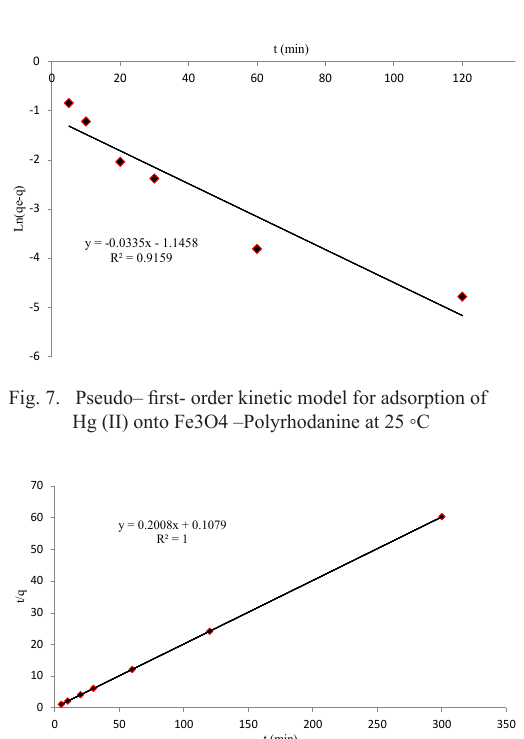
Fig.8: Pseudo-second-orderkineticmodelforadsorptionofHg(II)ontoFe 3 O 4 –Polyrhodanineat25 ◦ C Fig. 8. Pseudo- second- order kinetic model for adsorption of Hg (II) onto Fe3O4 –Polyrhodanine at 25